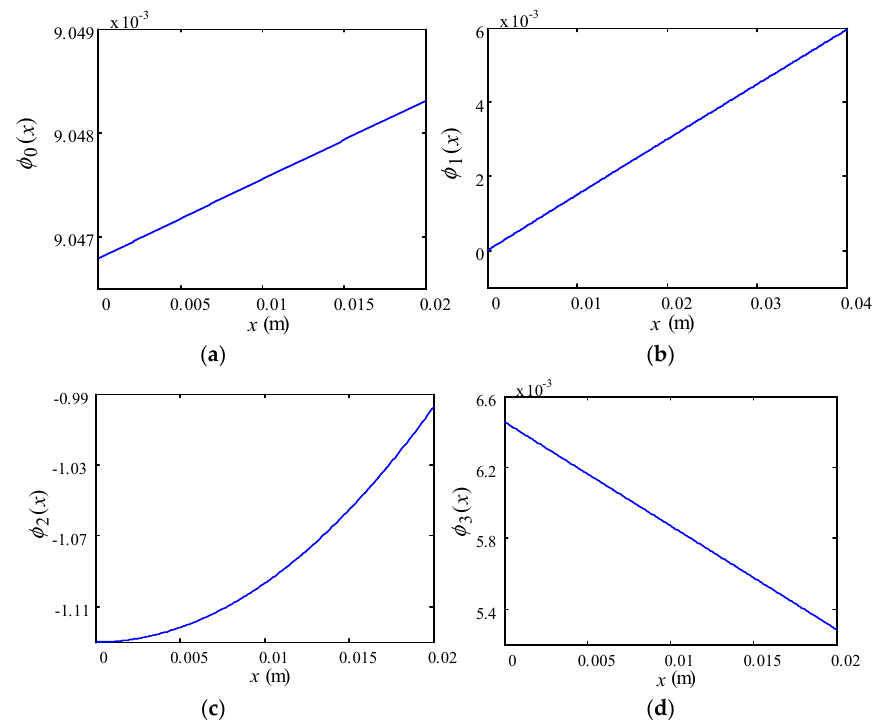
Figure 9. The 1st order modal function. ( a ) Piezoelectric stack; ( b ) beam AB ; ( c ) beam BC ; ( d ) intermediate shaft DE .